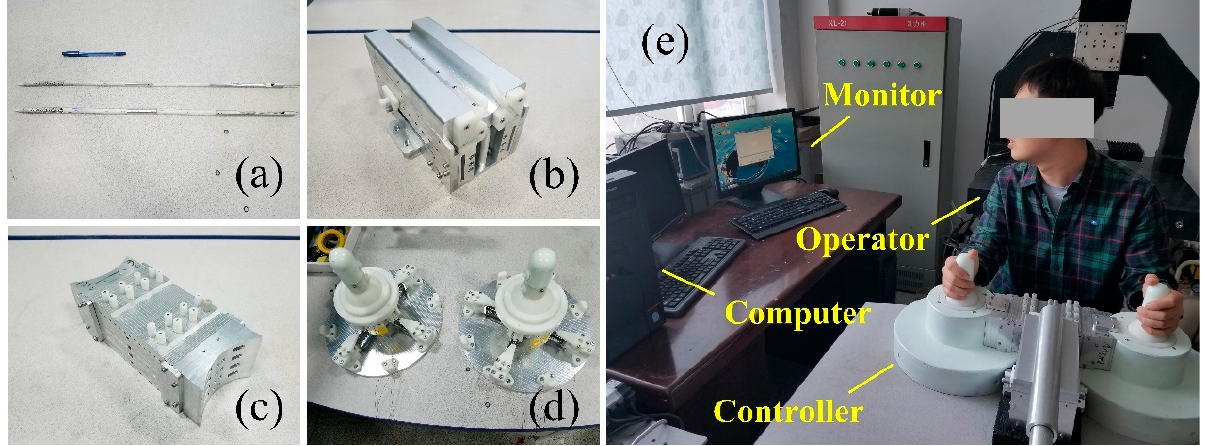
Figure 10. The prototype of the single-port MIS training platform: ( a ) instruments tube; ( b ) cords conveyor; ( c ) tensioner; ( d ) controllers; ( e ) operation the prototype of the platform.